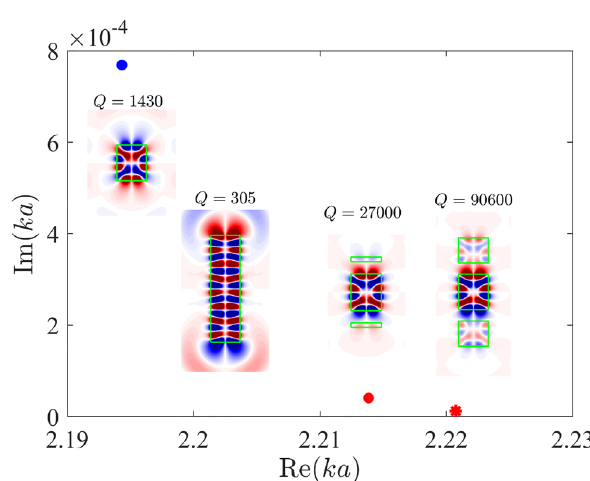
Figure 4: The Q -factors, resonant eigenfrequencies, and corresponding resonant modes. The first panel: A solitary disk with h = 2 . 41. The second panel: A single solid disk with sizes identical to those of disk’s arrangement shown in the fourth panel. The third panel: disk inserted symmetrically inside dimer of two thin disks = 0 . 303 , h = 2 . 378 , L = 0 . 781. The fourth panel shows the with h 1 = 1 . 688 , h = 2 . 367 , case of dimer with all scales optimized: h 1 L = 0 .